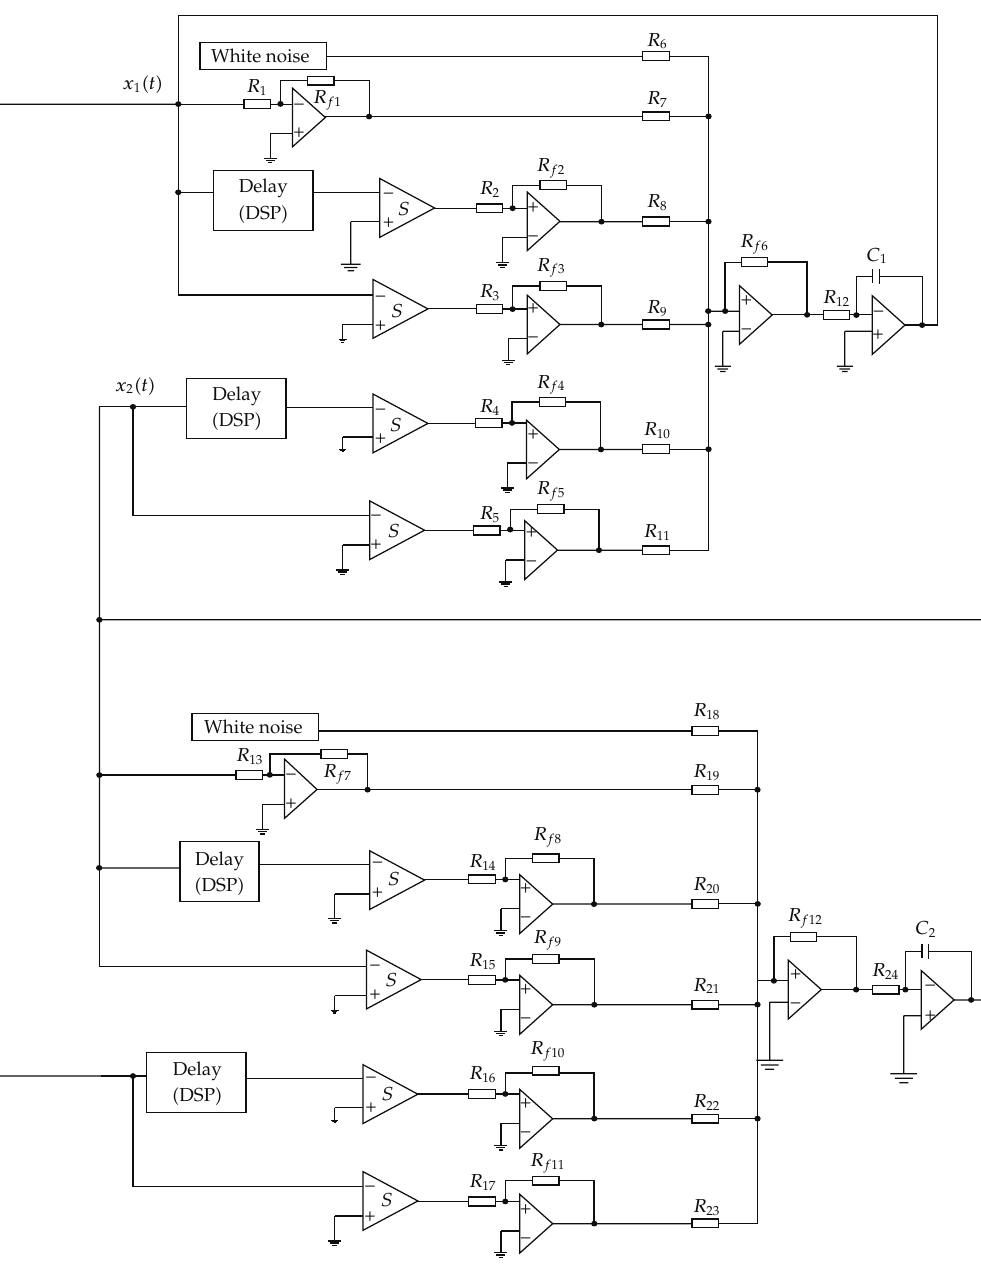
Figure 1: An analog circuit implementing of system (cid:2) 4.1 (cid:3)